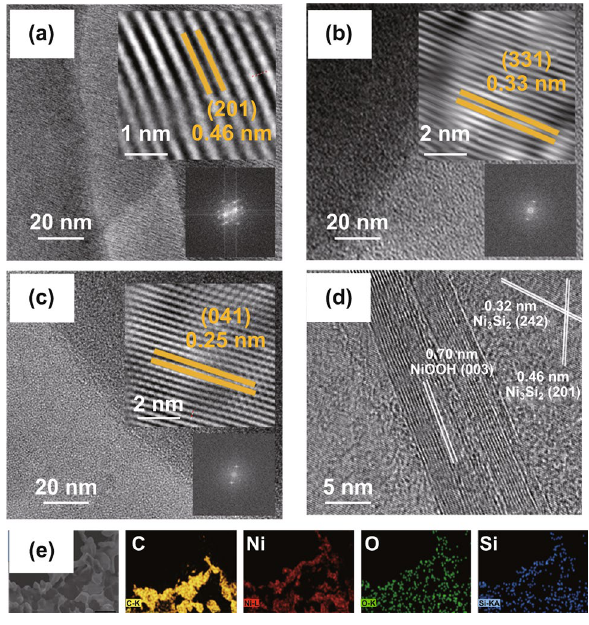
Fig. 4 a – d TEM images of Ni 3 Si 2 /NiOOH/graphene creeper-like nanostructures. e EDS scans of Ni 3 Si 2 /NiOOH/graphene creeper-like